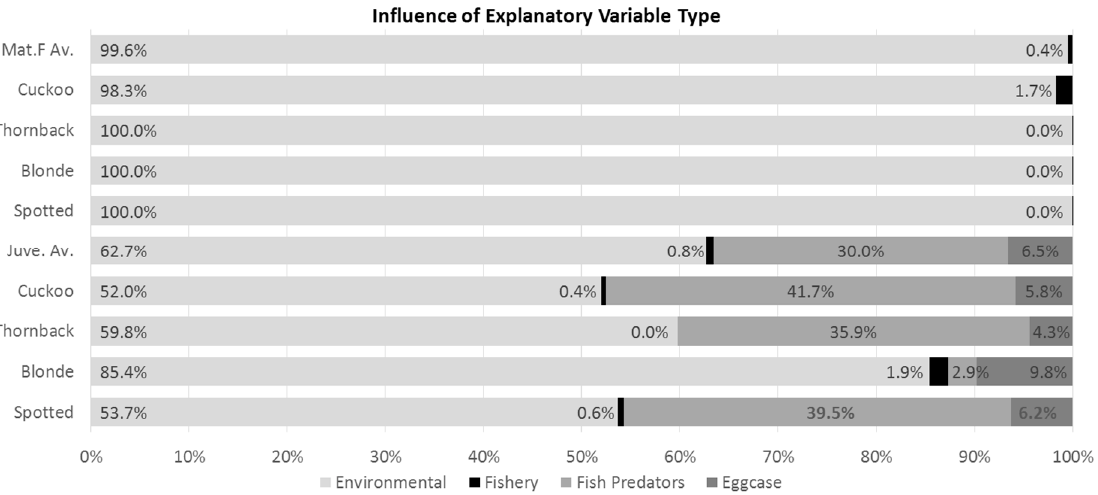
Figure 1. Average influence of grouped explanatory variable types, on mature female (top 5 rows; row 1 is mature female average) and juvenile (bottom 5 rows; sixth row is juvenile average) surveyed ray binary presence/absence plus Gaussian Catch Per Unit Effort (CPUE). Input data are the binary and Gaussian bar plot figures reproduced in Figure S2a–i.